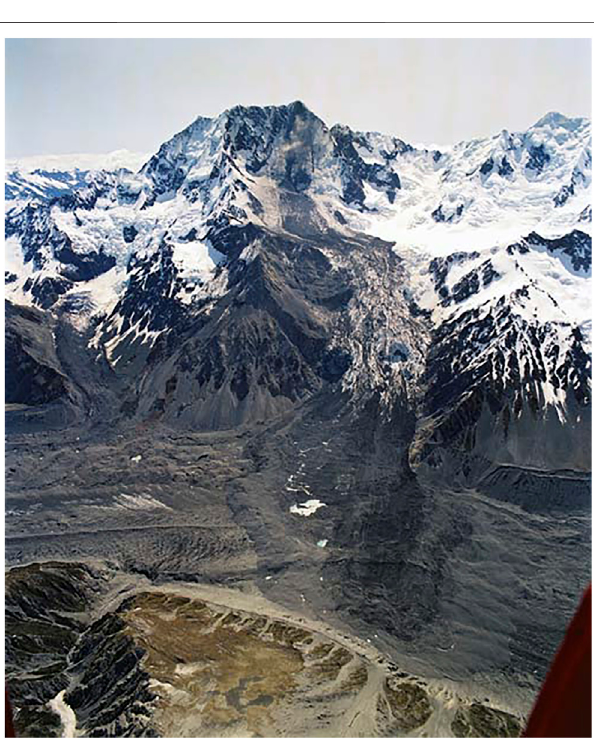
Frontiers in Earth Science |